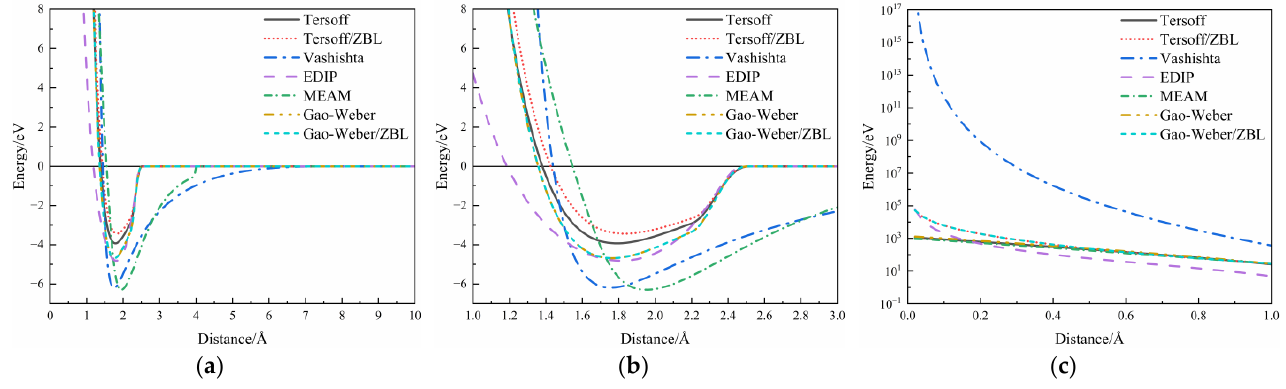
Figure 1. The Si-C interatomic interaction curves of the SiC potential functions: ( a ) Overview; ( b ) Medium-range; ( c ) Short-range [10,11,14,16,19 – 21].